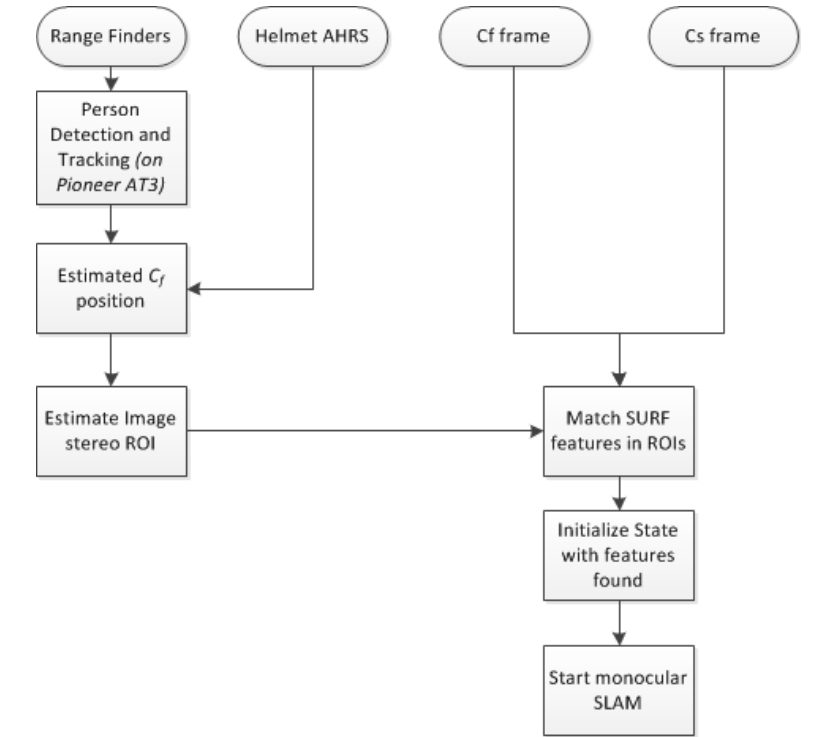
Figure 5. New metric scale initialization process.